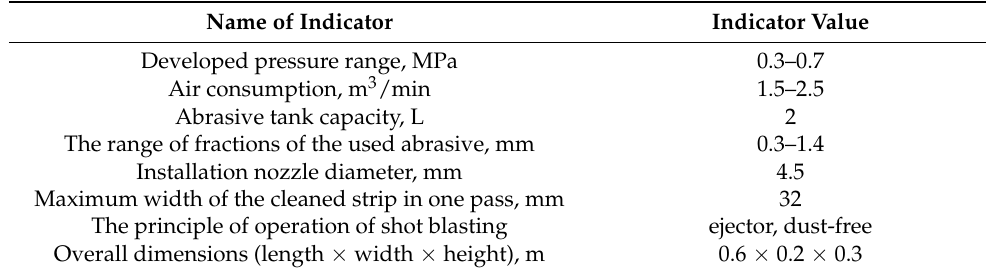
Table 2. Specifications of EDUCT-O-MATIC shot blasting machine